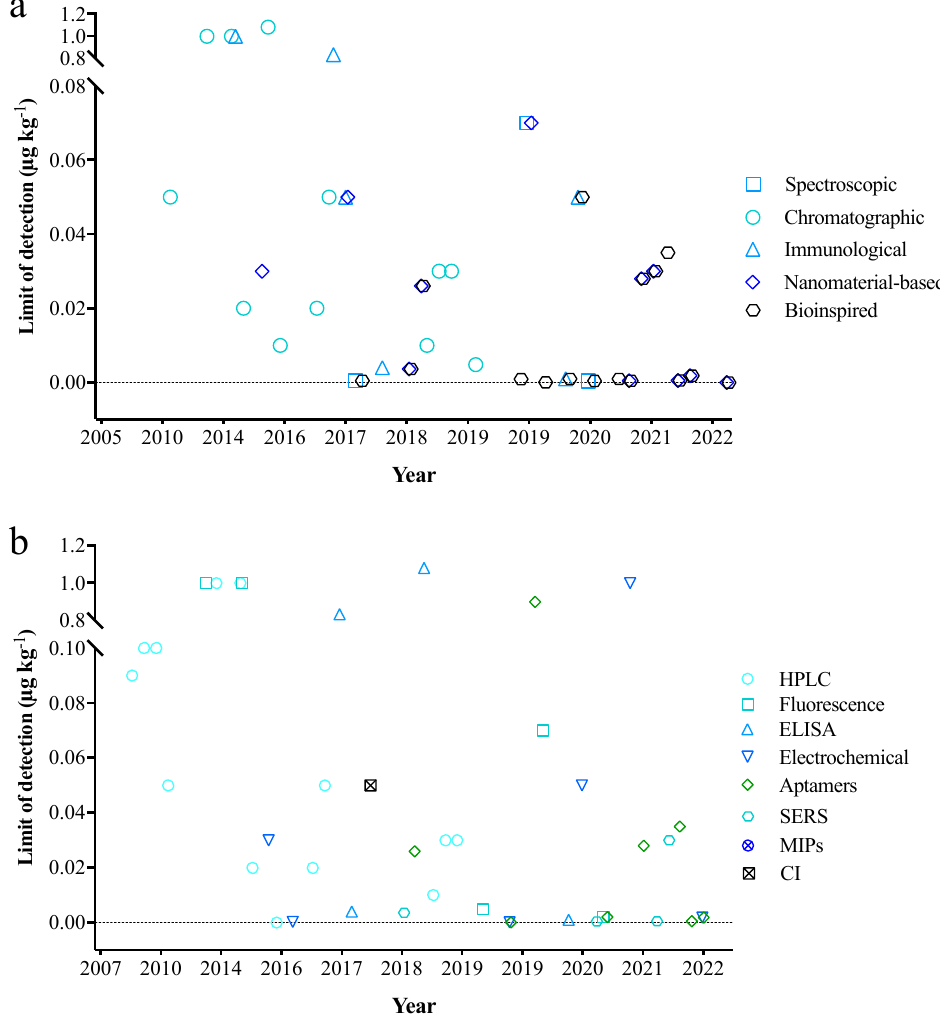
Figure 4. Timeline of the limit of detection on AFB 1 in edible oil by different ( a ) detection technology and ( b ) detection method. CI: Chemiluminescence immunoassay .